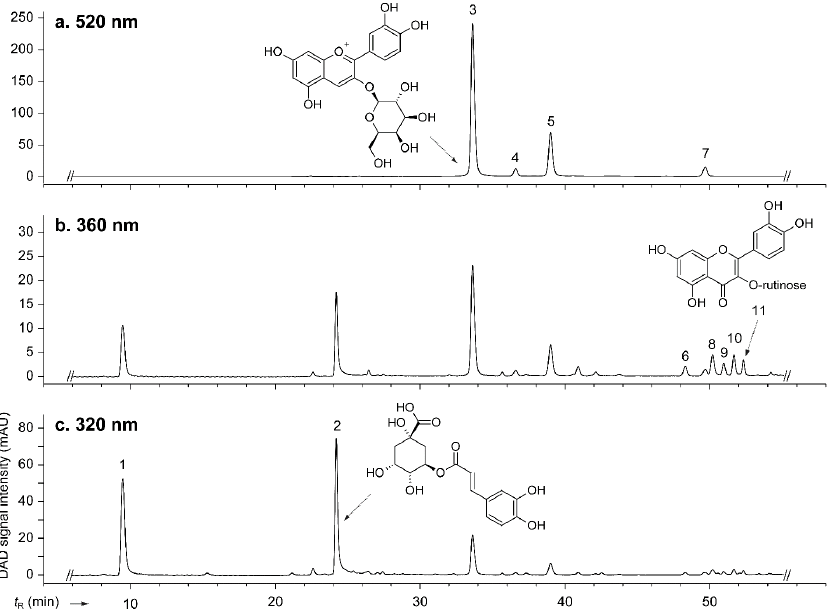
Fig. 2: HPLC separation of methanol/formic acid (95/5, v/v) extract of black chokeberry cv. 'Viking' at wavelengths of 520 nm (a), 360 nm (b), and 320 nm (c). Peak assignments: Neochlorogenic acid (1), chlorogenic acid (2), cyanidin 3- O -galactoside (3), cyanidin 3- O -glucoside (4), cyanidin 3- O -arabinoside (5), quercetin pentosyl-hexoside (6), cyanidin pentoside (7), quercetin 3- O -galactoside (8), quercetin deoxyhexosyl-hexoside (9), quercetin 3- O -glucoside (10), quercetin 3- O -rutinoside (11). Retention times and spectral characteristics are shown in Tab.